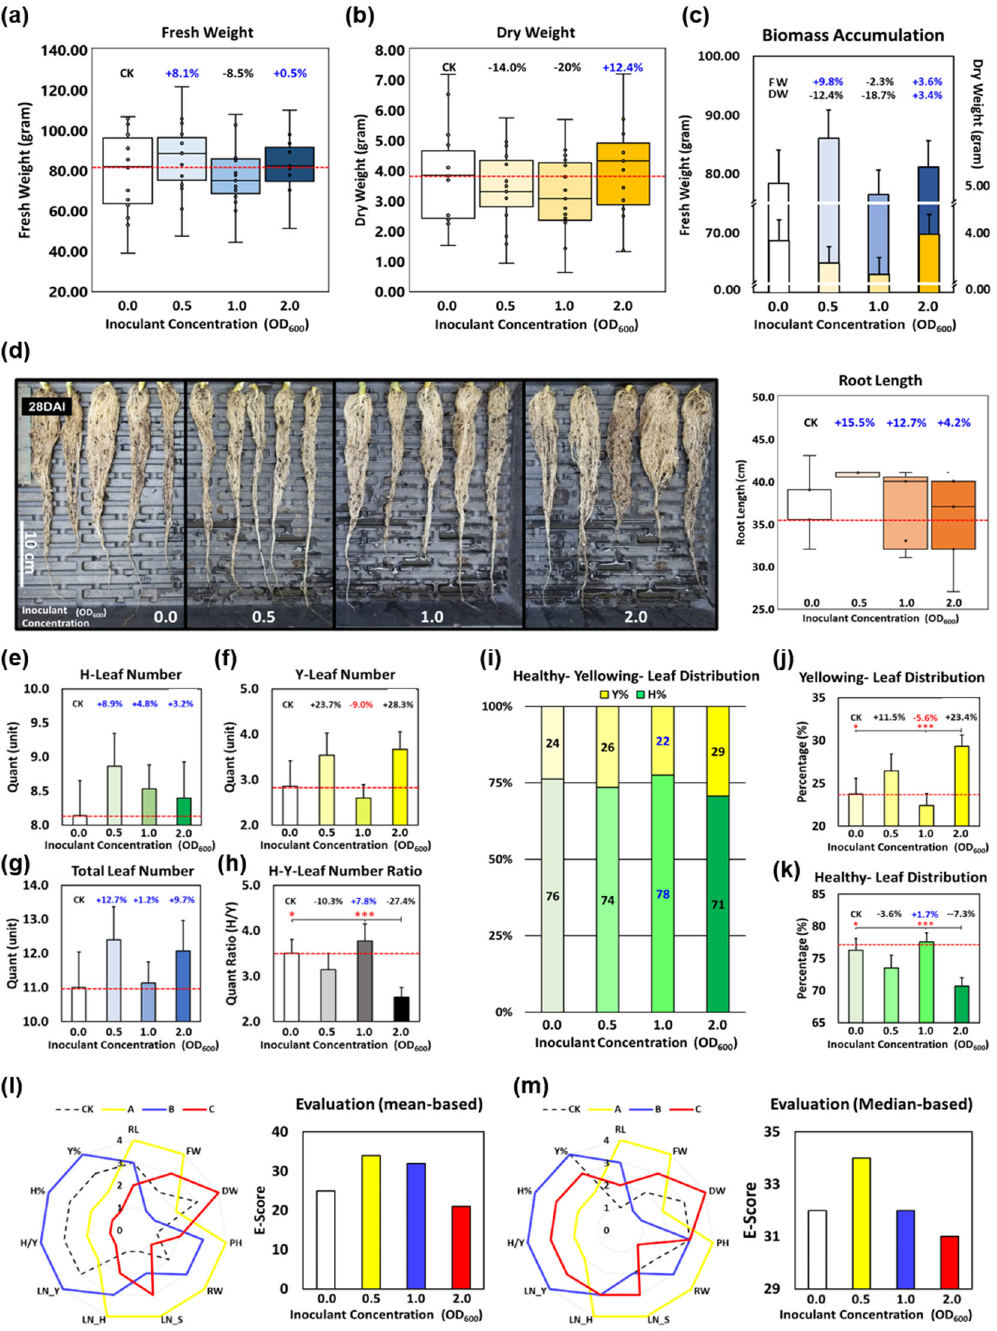
Figure 3. Effects of endophytic inoculant concentration on lettuce growth in the greenhouse. The lettuce seedlings were inoculated at the 4- to 5-leaf growth stage, harvested in the precupping growth stage, and all phenotypes were recorded 28 days after inoculation (DAI). ( a ) Median fresh and ( b ) dry weight; ( c ) biomass accumulation based on the mean fresh and dry weight. The ( d ) root length (left chart) and phenotype (right image); n = 5. The ( g ) total leaf number and shoot health indexes: ( e ) healthy leaf number, ( f ) yellowing leaf number, ( h ) healthy and yellowing leaf number, and ( i − k ) healthy and yellowing leaf distribution. The overall evaluation of the indexes’ e ff ects on